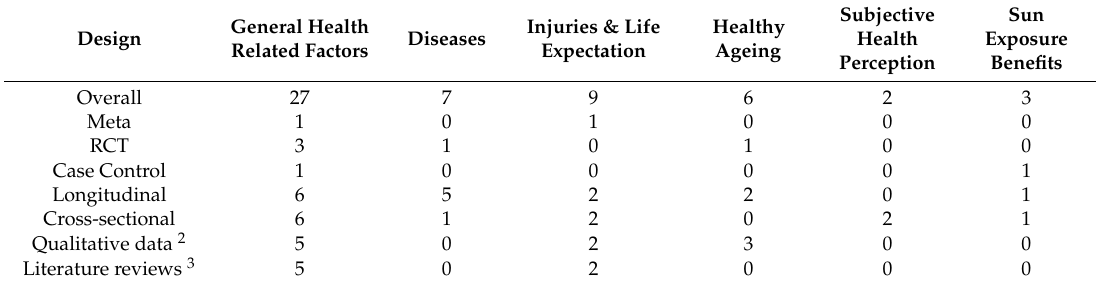
Table 4. Design of studies within physical health impacts 1